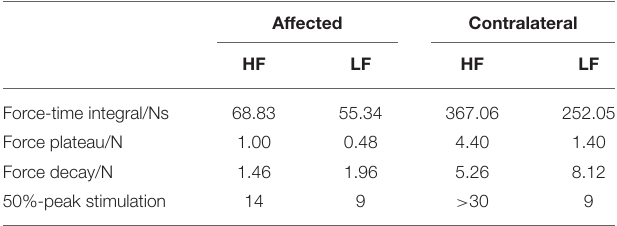
TABLE 1 | Comparison of fatigue